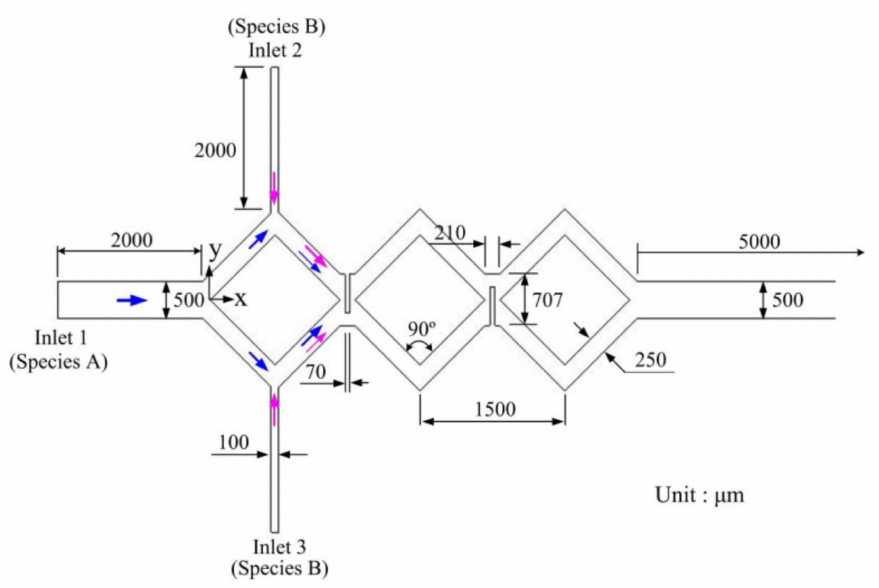
Figure 18. Schematic diagram of the modified rhombic micromixer with a turning angle of 90 ◦ and two baffles. Different gap ratios were considered to investigate the mixing